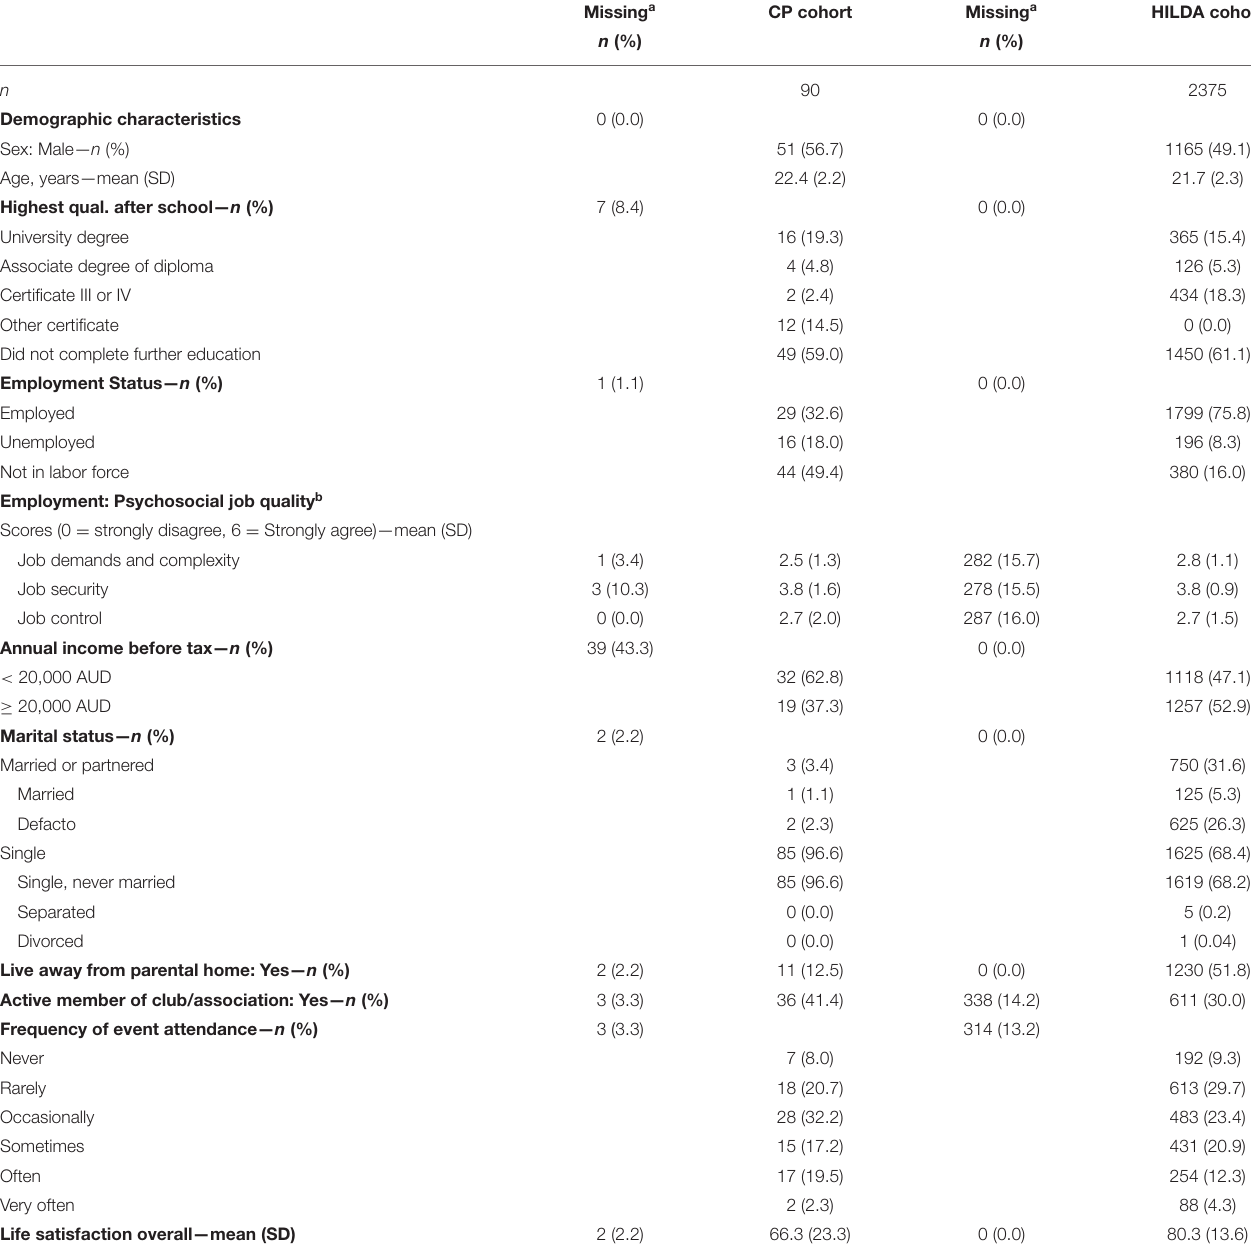
TABLE 4 | Comparison of demographic characteristics and social outcomes for CP and HILDA cohorts. Missing a CP cohort Missing a HILDA